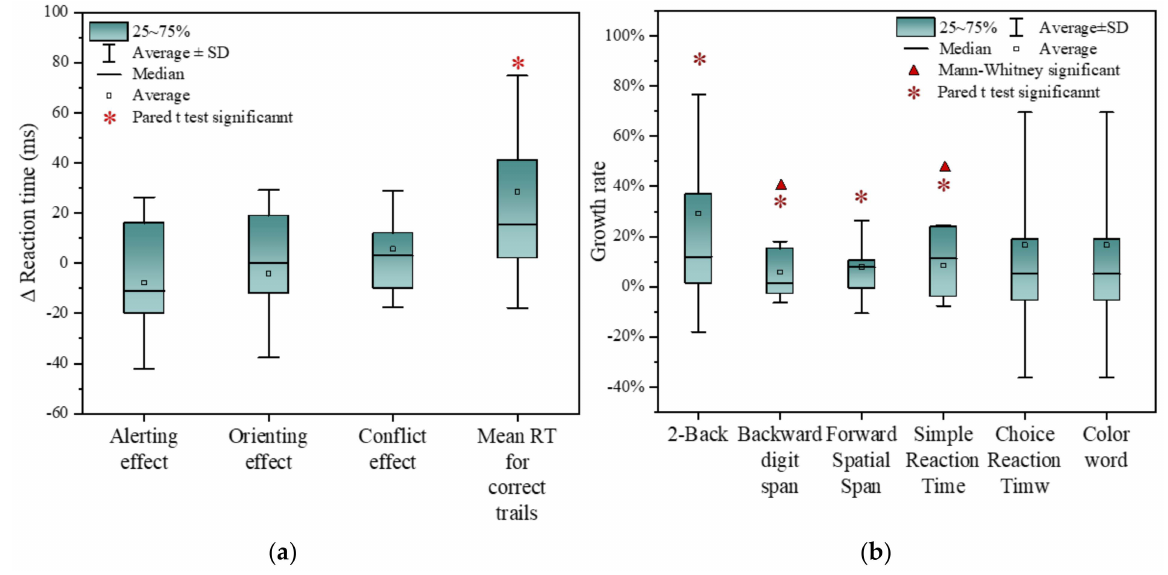
Figure 6. Differences of the results for ( a ) the ANT and ( b ) the Mind Qualified platform before and after the exposure to the forest park. The score differences for the Mind Qualified platform were normalized against the scores before the